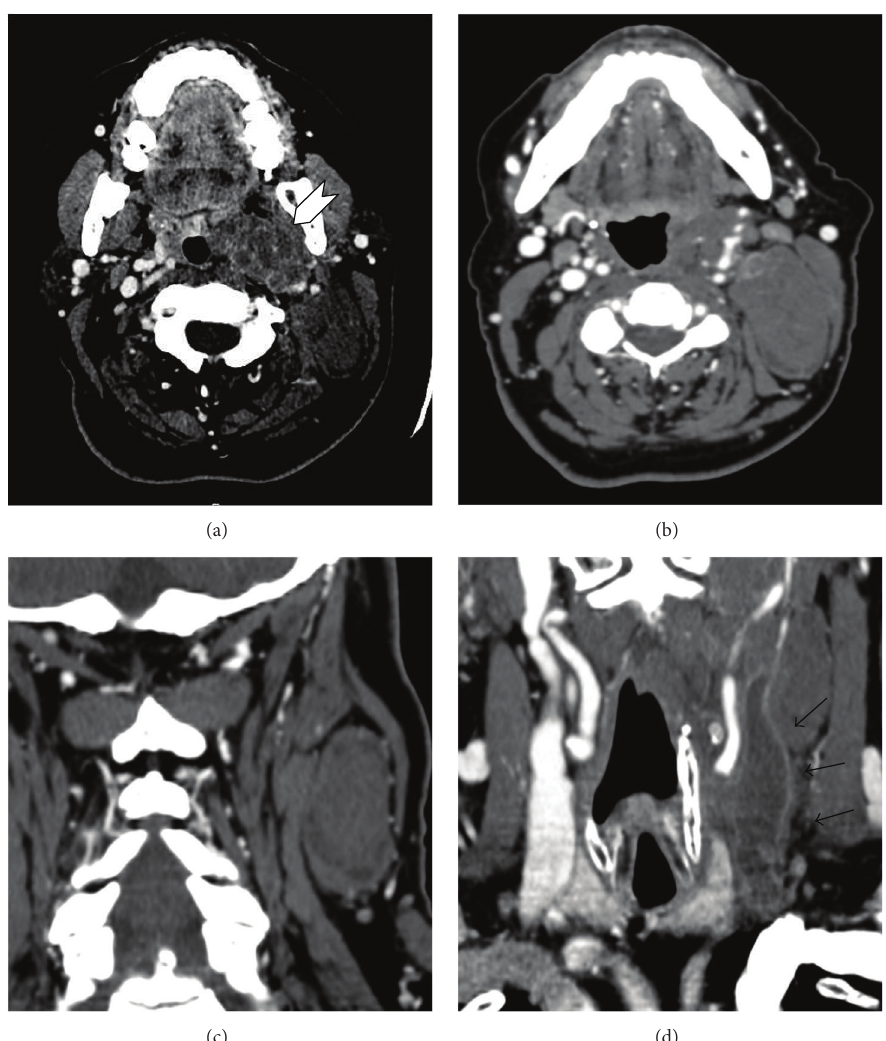
Figure 1: CT scan shows an expansive lesion in the left PPS. (a-b) Axial CT scan after injection of contrast medium shows an inhomogeneous contrast enhancement of the mass in the left PPS; (c) coronal-MPR shows the extension of the lesion in the ipsilateral laterocervical space; (d) the mass compress the ipsilateral the left internal jugular vein with an evident cleavage plane; the vein presents an extensive thrombosis.